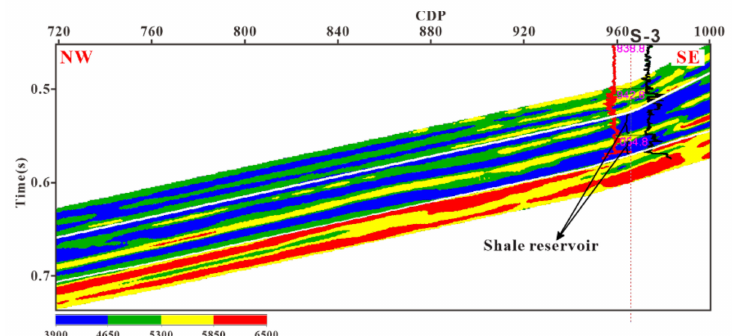
Figure 12. Inverted velocity (m/s) section connecting well S-3. NW and SE denote the northwest and southeast directions of the study area, respectively. The two white lines are the top and bottom interfaces of Longmaxi Formation. Near well S-3, the red and black curves, respectively, are the GR and acoustic velocity logging curves, and the pink scale is the vertical depth